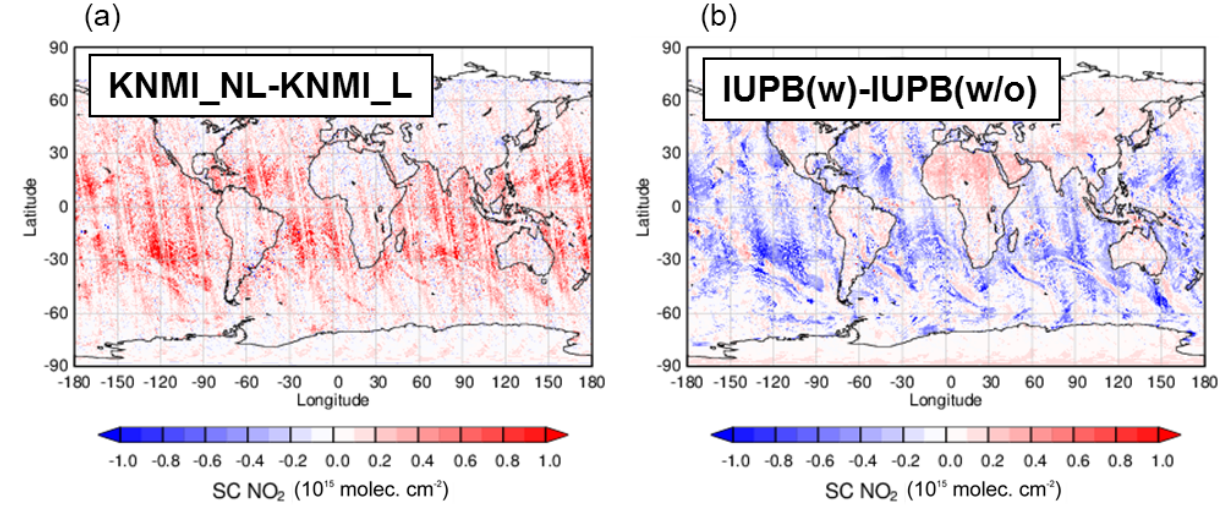
Figure 3. OMI NO 2 slant column differences between KNMI intensity (KNMI_NL) and optical density fit (KNMI_L) (a) and IUPB fit including (IUPB(w)) and excluding the intensity offset (IUPB(w / o)) (b) . Data are from 2 February 2005. The units of the colour bar in both panels are 10 15 molec.cm − 2